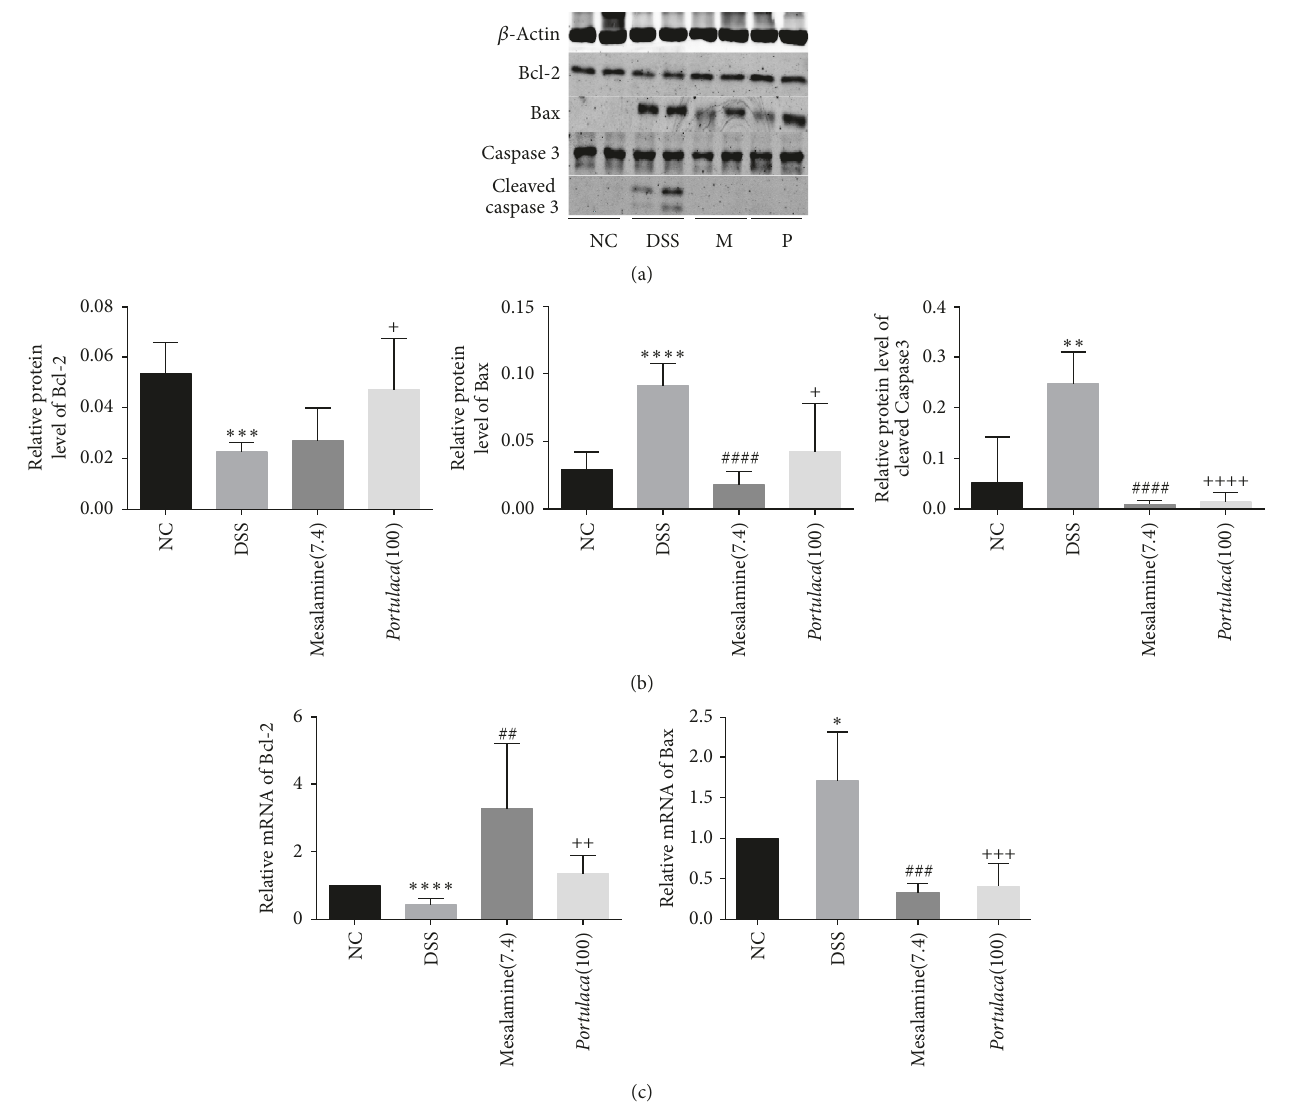
Figure 4: Effects of Portulaca extract on apoptosis in mice on inflammatory bowel disease. Panel (a) shows the protein level of Bcl-2, Bax, caspase 3, and cleaved caspase 3 in each group. Panel (b) represents the histogram of density for Bcl-2, Bax, and cleaved caspase 3. Panel (c) represents the relative mRNA level of Bcl-2 and Bax from quantitative real-time PCR, respectively. (Data are presented as mean ± SD from six experiments. ∗ indicatescomparisonbetweenDSSandNC;#indicatescomparisonbetweenmesalamineandDSS;+indicatesthecomparison between Portulaca and DSS. The number of symbols indicates significance of difference; for example, four symbols indicate 𝑝 < 0.0001 ; three symbols indicate 𝑝 < 0.001 ; two symbols indicate 𝑝 < 0.01 ; and one symbol indicates 𝑝 < 0.05